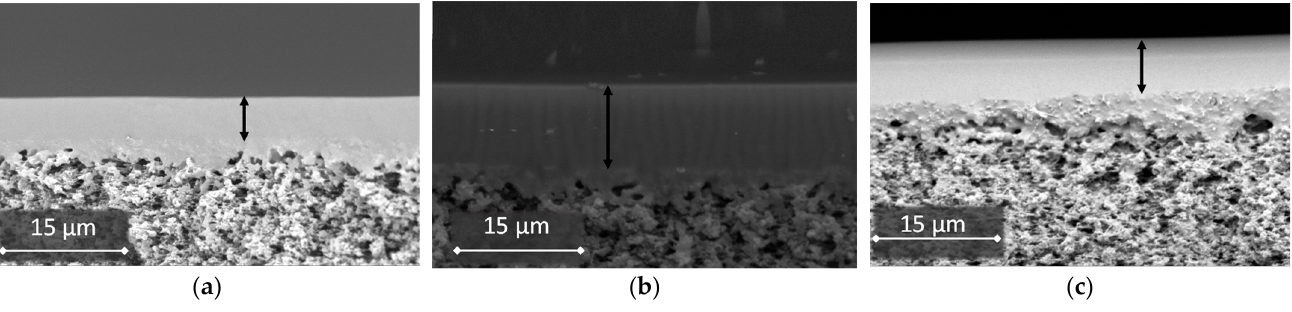
Figure 9 . SEM images of samples of the flat composite membranes: ( a ) POMS/MFFK, 6 µm; ( b ) Figure 9. SEM images of samples of the flat composite membranes: ( a ) POMS/MFFK, 6 µ m; Ag1/MFFK, 10 µm; ( c ) Ag9/MFFK, 8 µm. ( b ) Ag1/MFFK, 10 µ m; ( c ) Ag9/MFFK, 8 µ m. The membrane was exposed to the flow of an ethylene/ethane mixture for 3 h